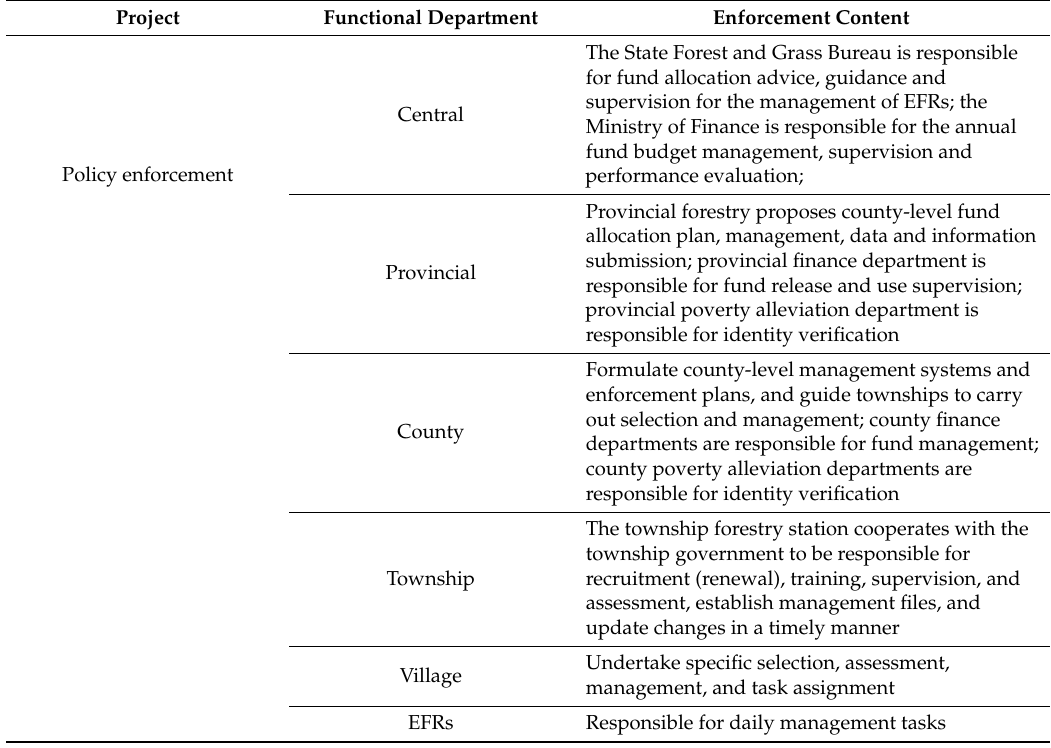
Table 2. Division of responsibilities of administrative departments at all levels.